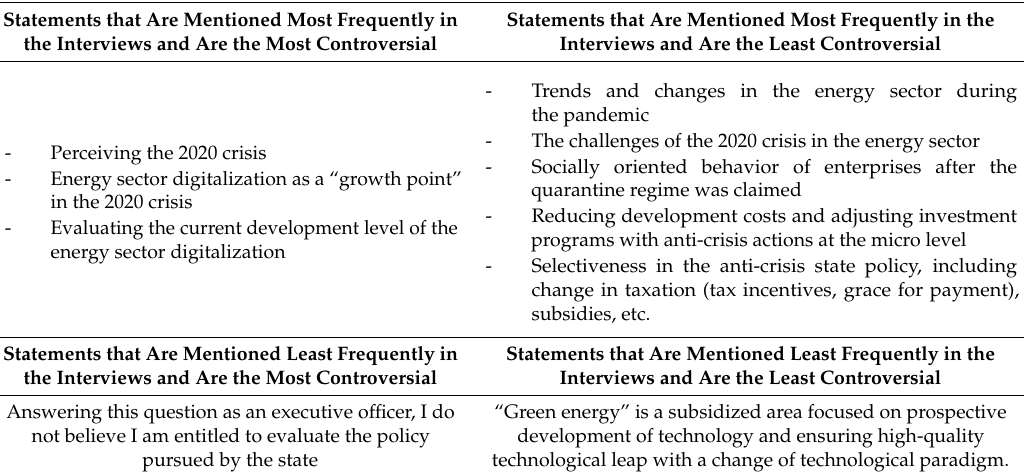
Table 2. Analyzing experts’ opinions—generalized data of the in-depth